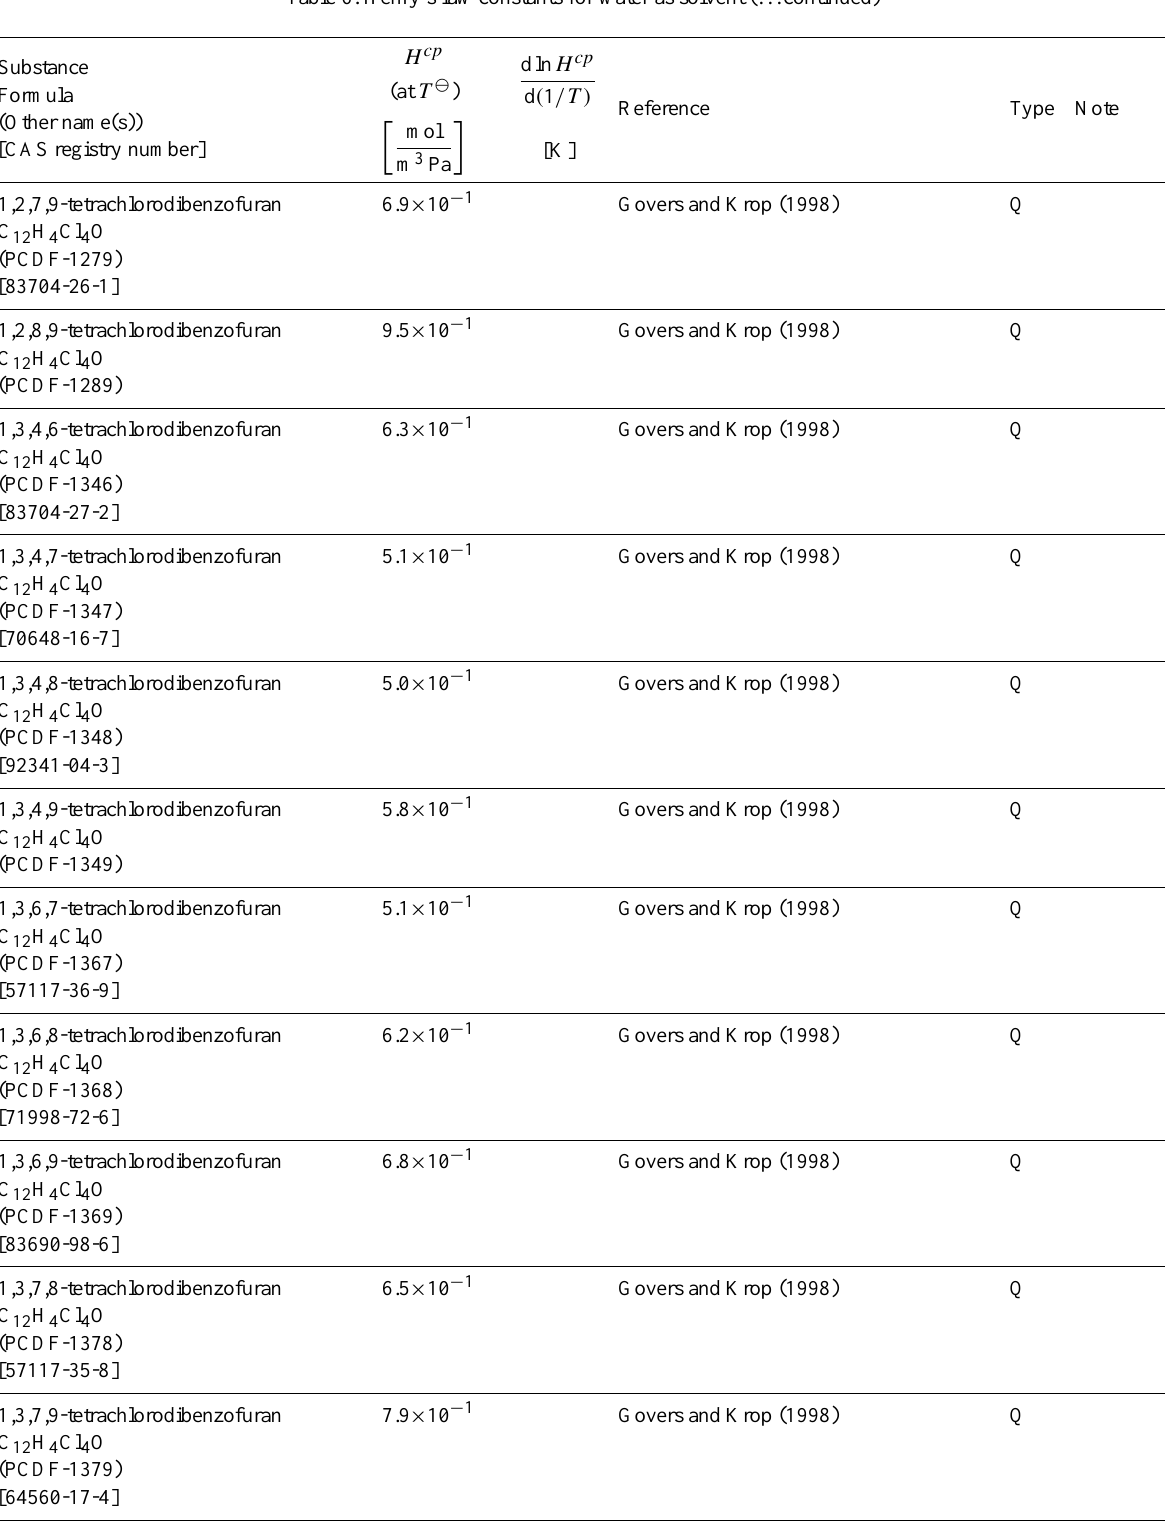
Table 6: Henry’s law constants for water as solvent